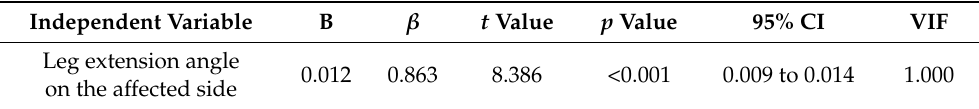
Table A2. Dependent variable: Increment of velocity on the affected side. Independent variable: BBS, MI-LL, leg extension angle on the affected and non-affected side.